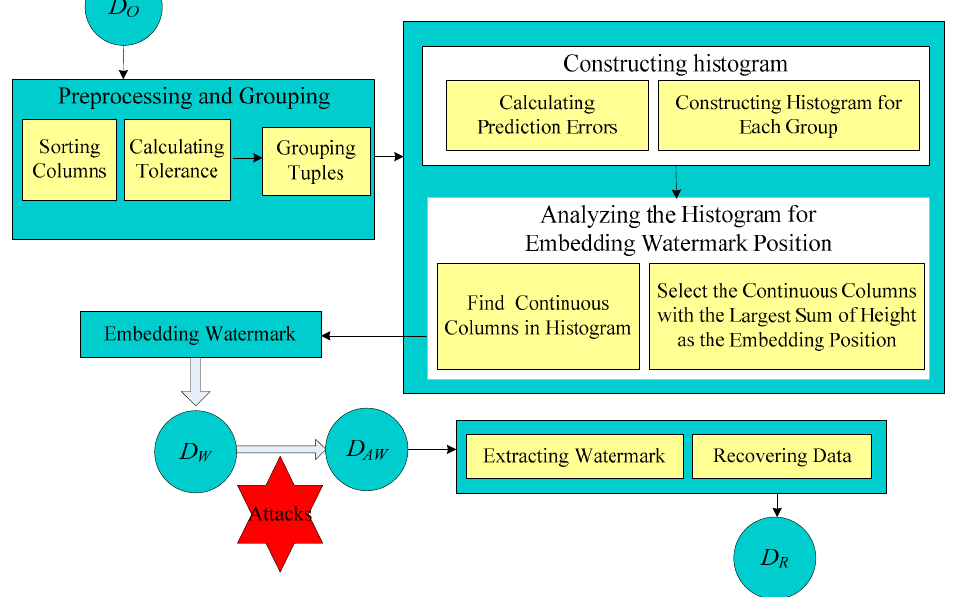
Figure 1. Schematic diagram of the relational database based on continuous columns in histogram (RCW) method.